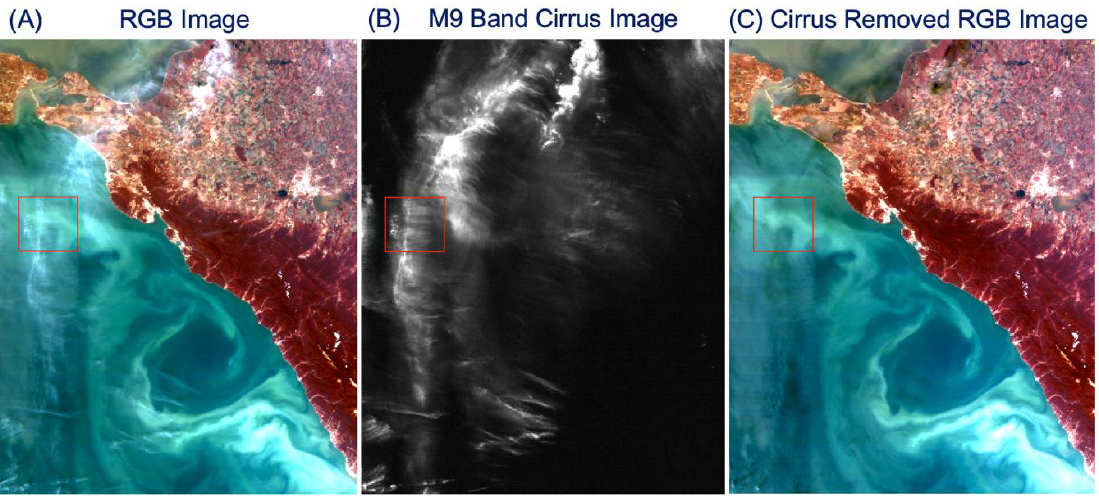
Figure 9. A portion of a VIIRS RGB image over eastern part of Black Sea and nearby areas ( A ), the M9 band apparent reflectance image ( B ), and the cirrus-removed RGB image ( C